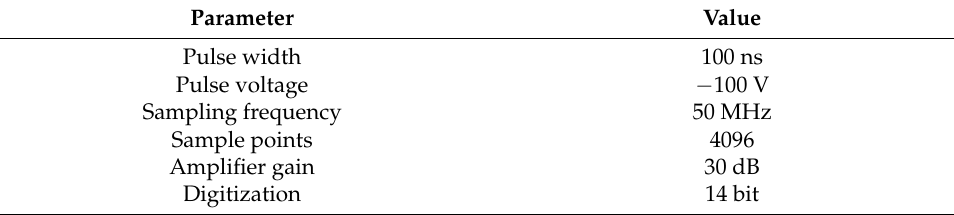
Figure 6. The geometry of oblique incidence situation for experiment. Table 3. Parameters for transmission and reception in Table 3. Parameters for transmission and reception in experiment.